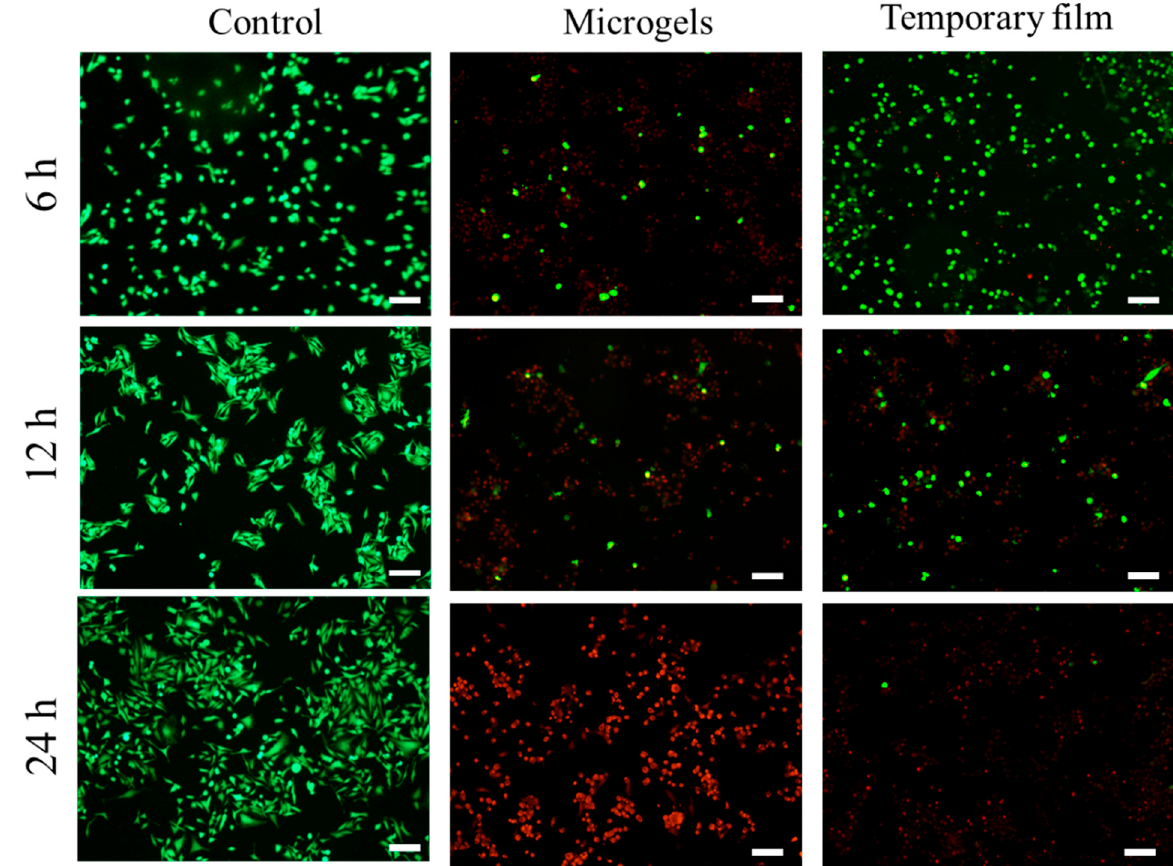
Figure 7. Live (green)/dead (red) staining Hela cells for PCD film (control), microgels, and temporary film samples. Scale bar: 100 μ m.